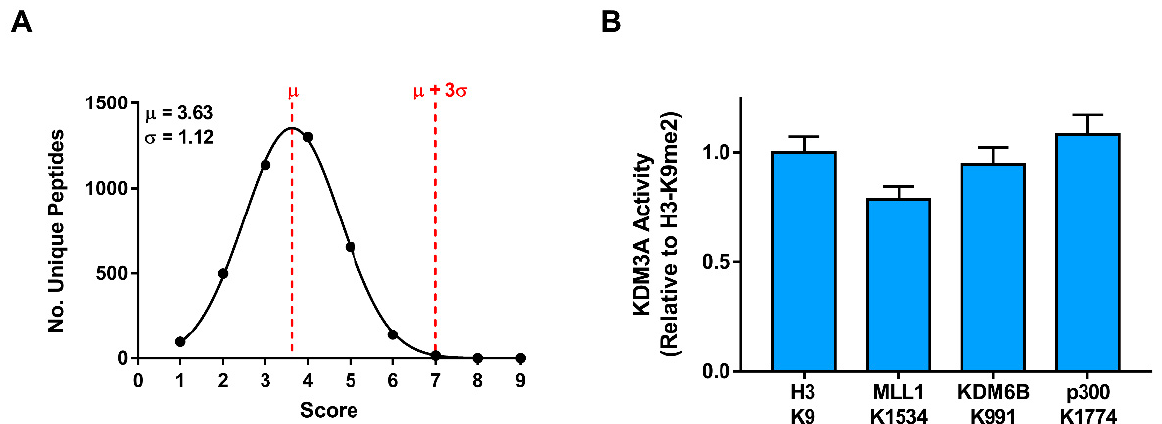
Figure 4. Substrate prediction and validation. ( A ) Distribution of scored peptides within the KDM3A interactome. Distributions represent scoring with a low ‐ stringency KDM3A recognition motif (i.e., 0.5 threshold). All peptides ranking greater than or equal to three standard deviations ( σ ) above the mean ( μ ) score are provided in Supplementary Table S2. Gaussian curves were fitted with GraphPad Prism. ( B ) Identified KDM3A in vitro substrates displaying at least 50% relative H3 ‐ K9me2 demethylation. KDM3A activity was monitored towards K ‐ centered 15 ‐ mer peptides, where the central di ‐ methylated lysine residue is shown on the x ‐ axis.